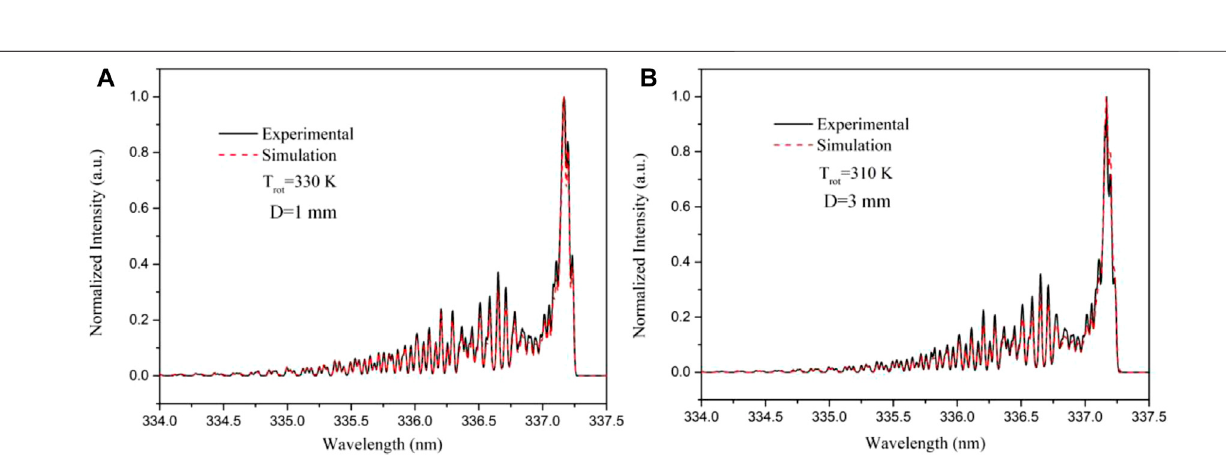
FIGURE11| ExperimentalandsimulatedspectraoftheN 2 (337 nm)emission. (A) Samplingpointisintheafterglowregions,D=1 mm. (B) Samplingpointisinthe afterglow regions, D = 3 mm. The simulation spectra are obtained by